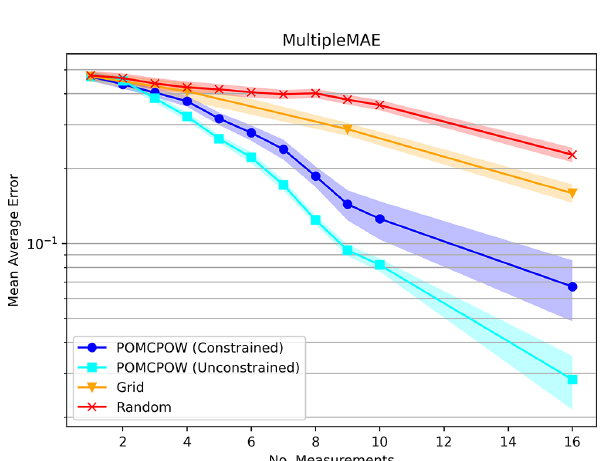
Figure 25. Relative MAE, two mineralization processes. The plot shows the mean relative absolute error after a given number of mea- surements taken under each tested method. The mean absolute error is shown along with 1 standard error bounds for each trend.